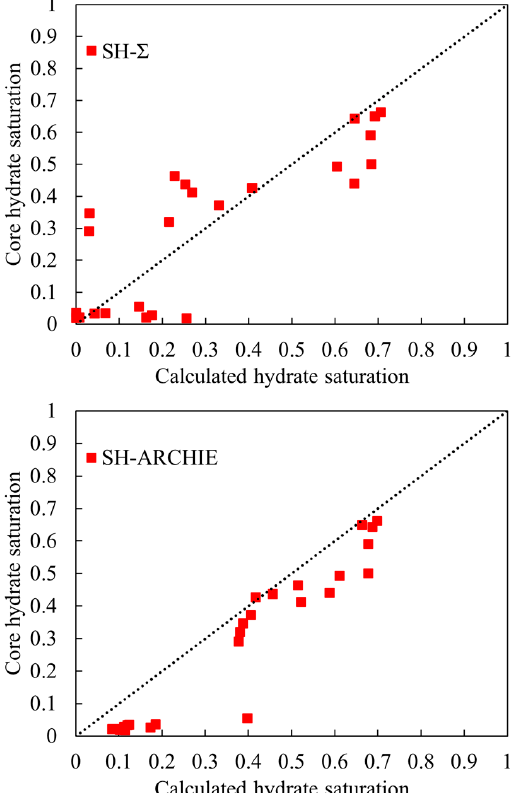
Figure 12. Comparison of various methods for the calculation of logging saturation with core satu- ration.